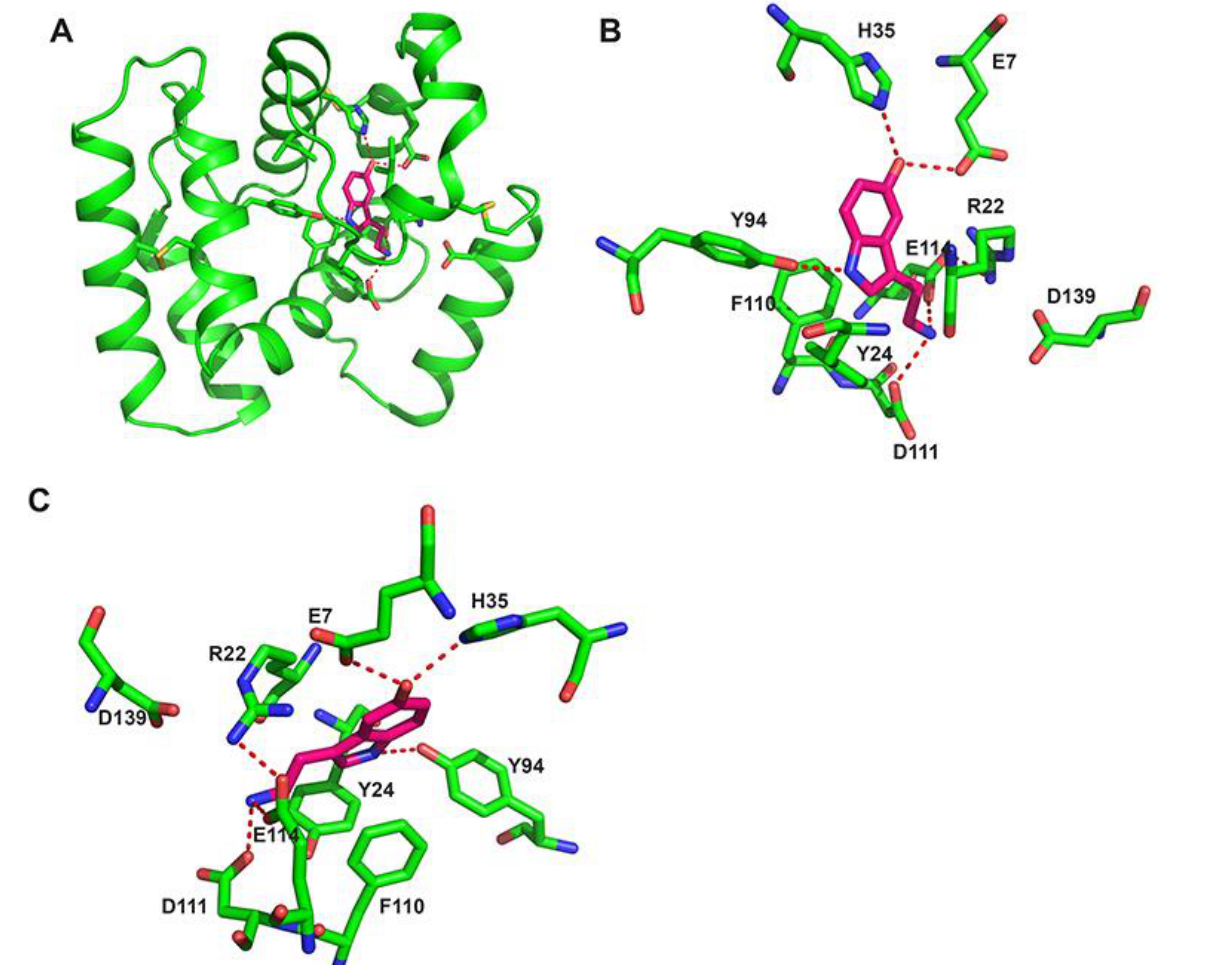
Figure 3. Details of Anopheles gambiae D7r4 biogenic amine binding pocket — ( A ) Ribbon diagram of An. gambiae D7r4-serotonin complex (PDB:2QEH). ( B , C ) Two different views showing details of An. gambiae D7r4 bound to serotonin (PDB:2QEH) [28]. Protein helices and residues forming the biogenic amine binding pocket (labeled with one letter code and position) are shown in green, and serotonin is in hot pink. Cysteines forming the 3 disulfide bonds (DS 1–3) are also shown and labeled. Oxygens atoms are colored in red, nitrogen atoms in blue and sulfur in yellow. H-bonds are indicated as red dashed lines.